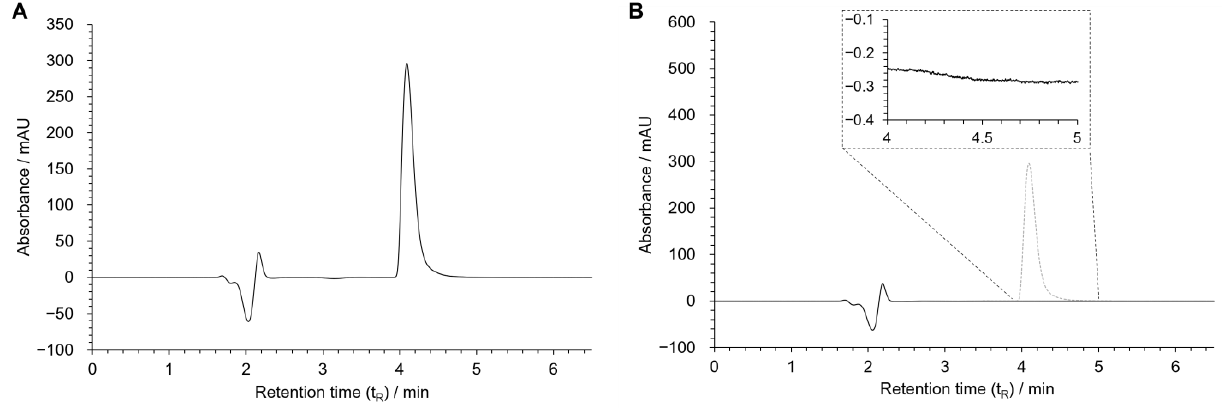
Figure 4. Chromatograms of MDPV [100 µM in HBSS(+/+)] ( A ), and blank sample [HBSS (+/+)] ( B ). Chromatographic conditions: Kinetex ® EVO C18 column, 25 mM NH₄CH₃CO₂: CH₃CN: HCOOH (75:25:0.1 v / v / v ) as the mobile phase, flow rate: 0.12 mL/min, UV detection: 236 nm.